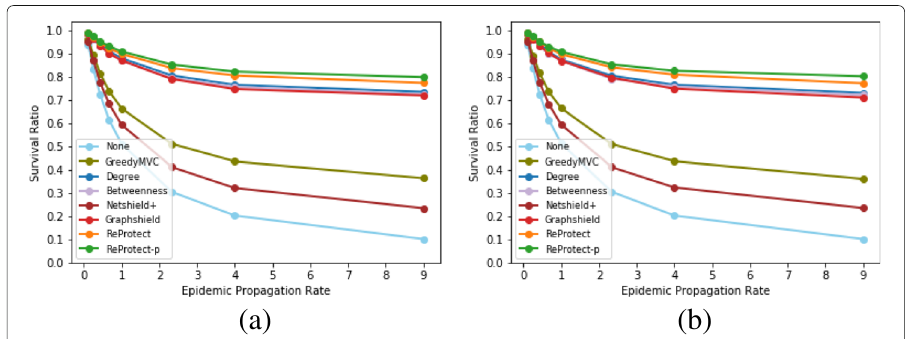
Fig. 9 Evaluation of sensitivity to the epidemic propagation rate (the ratio of β δ ). Higher is better. a SIS Model. b SIR